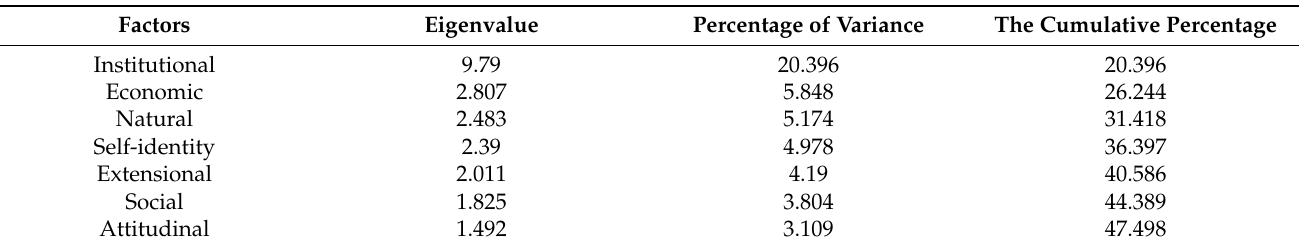
Table 5. Extracted factors along with specific values, percentage of variance, and cumulative variance.